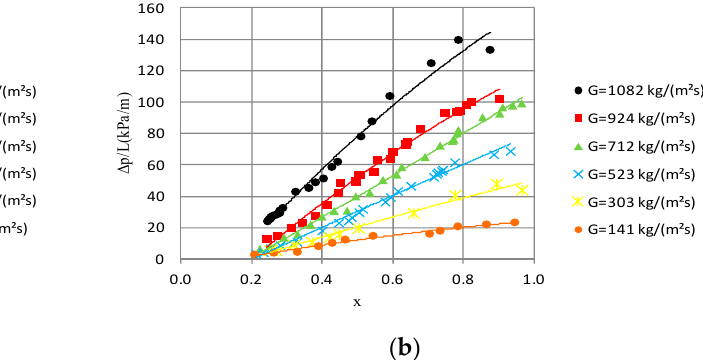
Figure 8. Dependence of pressure drops on average vapor quality ( Δ p/L) = f(x a ) for few mass flux densities G during HFE 7000 condensation in minichannels with internal diameter: ( a ) d i = 1.2 mm, inlet T s = 39 °C; ( b ) d i = 2.5 mm, inlet T s = 42 °C.